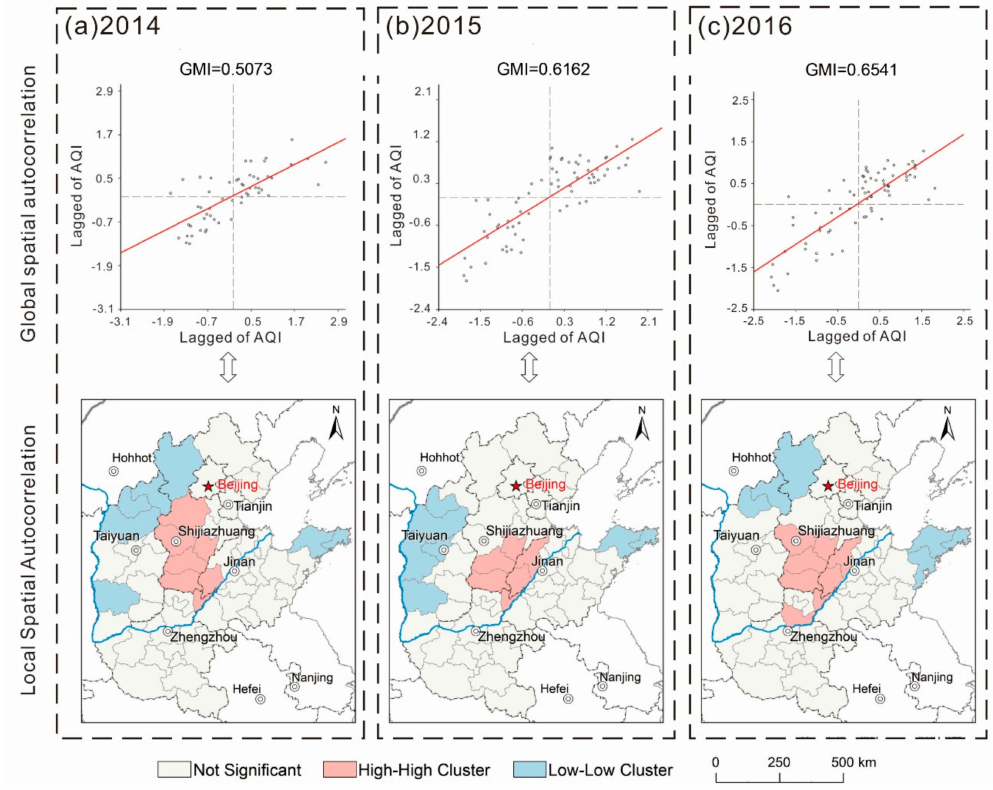
Figure 7. ( a – c ) Scatter plots of Global Moran Index (GMI) and local index of spatial association (LISA) agglomeration in North China (2014–2016). The abscissa represents the standardized AQI in cities and the ordinate represents the space lag vector which is the neighboring AQI as determined by the spatial weight weighting matrix. The GMI scatter plots are divided into four quadrants including H-H (upper right), L-L (lower left), H-L (lower right), and L-H (upper